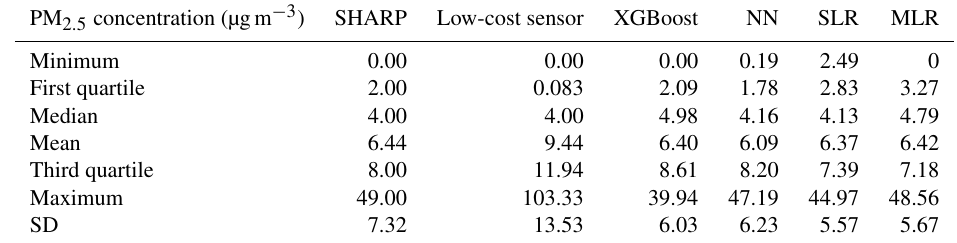
Table 8. Descriptive statistics of PM 2 . 5 concentrations using the test